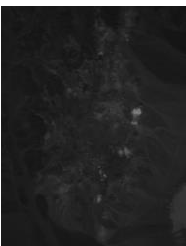
Figure 1. Band 3 of real data scene.